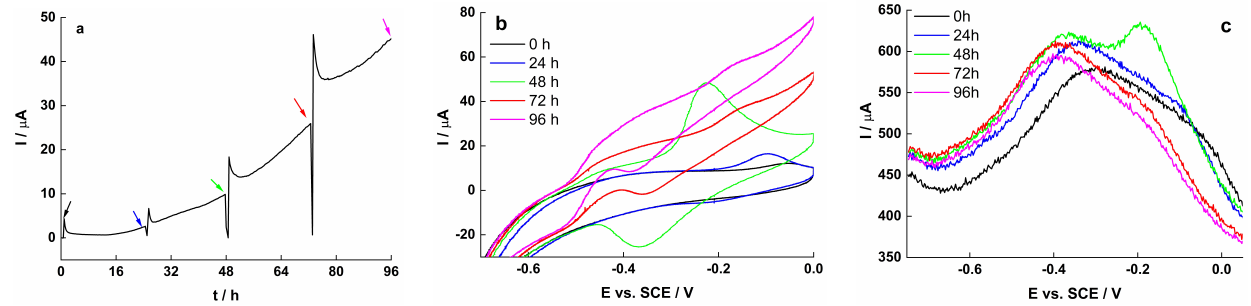
Figure 7. ( a ) CA, ( b ) CV and ( c ) DPV of S. loihica PV-4 biofilm on RVC. The color of the arrows in the CA corresponds to the color of the CV and DPV traces.